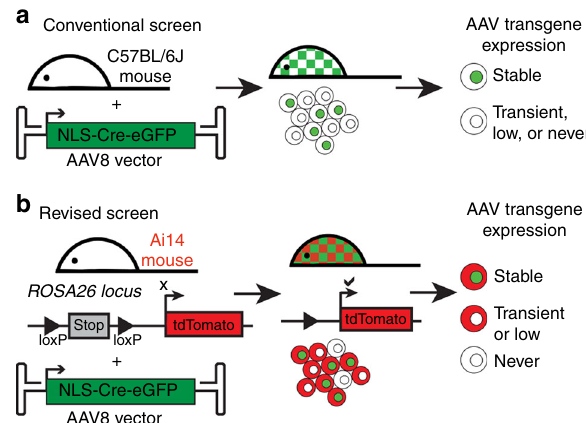
Fig. 1 Comparison of conventional and revised AAV tropism screening methods. a Following injection of AAV2/8.CMV.HI.eGFP-Cre.WPRE.SV40 (AAV8-Cre-eGFP) into C57BL/6J mice, only the subset of cells with stable, high transgene expression will show nuclear-localized eGFP. Cells with transient or low transgene expression are missed. b Injection of the same AAV8-Cre-eGFP vector into Ai14 reporter mice (containing an endogenous loxP-STOP-loxP-tdTomato locus) captures cells with stable, high transgene expression (green nuclei) as well as cells with transient or low expression of the AAV transgenes (Cre-tagged tdTomato positive